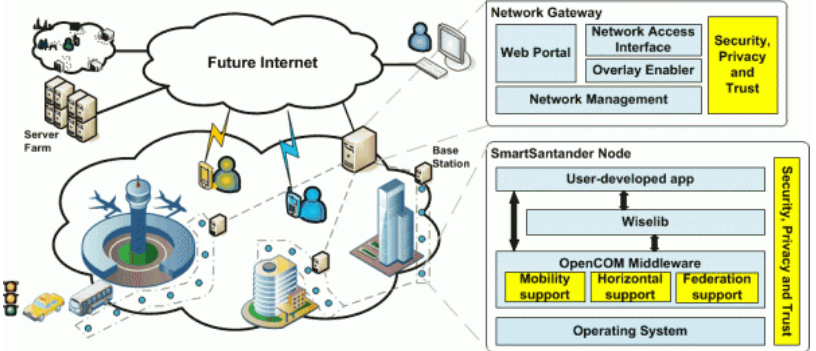
Figure 1. SmartSantander system architecture overview. Taken from